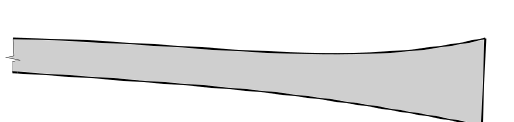
Figure 1. One of the shapes of the trailing edge used for the swirl line investigation.